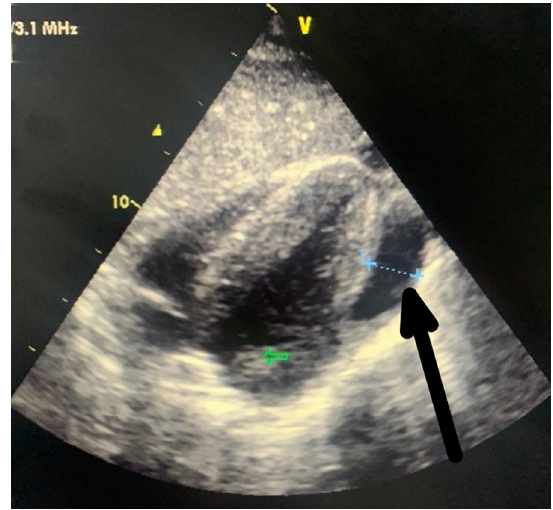
Fig. 1 Transthoracic echocardiography showing the pseudoaneurysm of the left ventricular free wall (arrow)